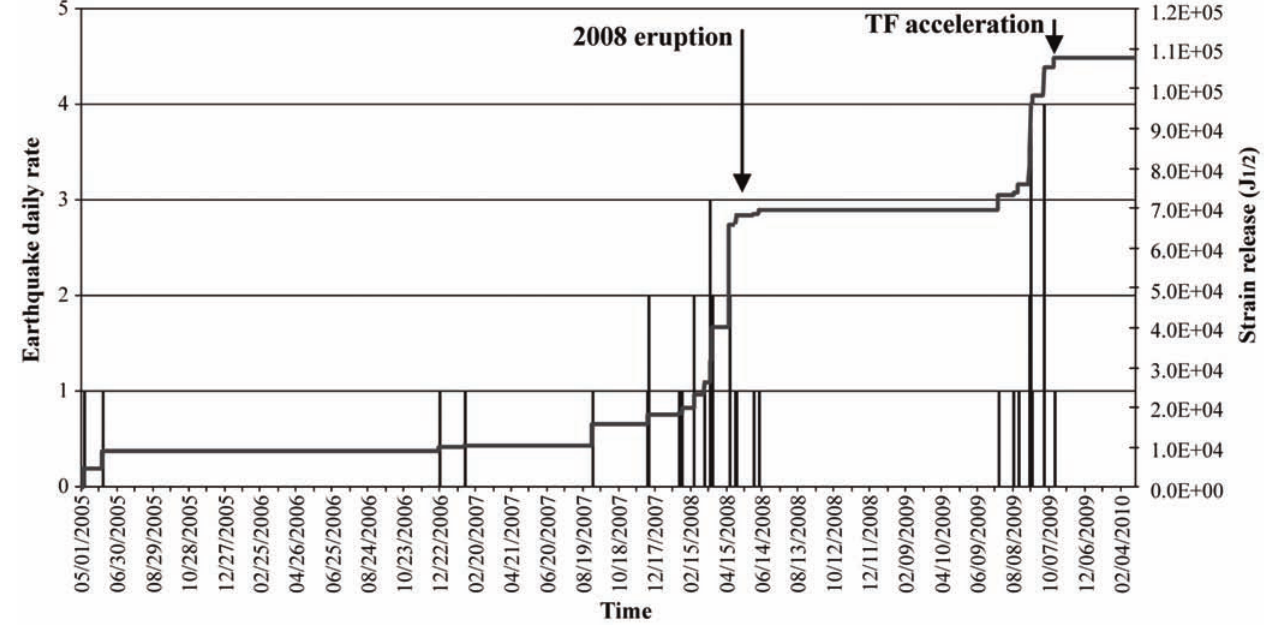
Figure 7. Earthquake daily rate and related strain release of the May 2005 to February 2010 seismicity that occurred in the narrow area reported in Figure 6D. The seismic strain release has been calculated as √ E with the following relationship [Richter 1958]: Log E = 9.9 + 1.9 M M is the duration d